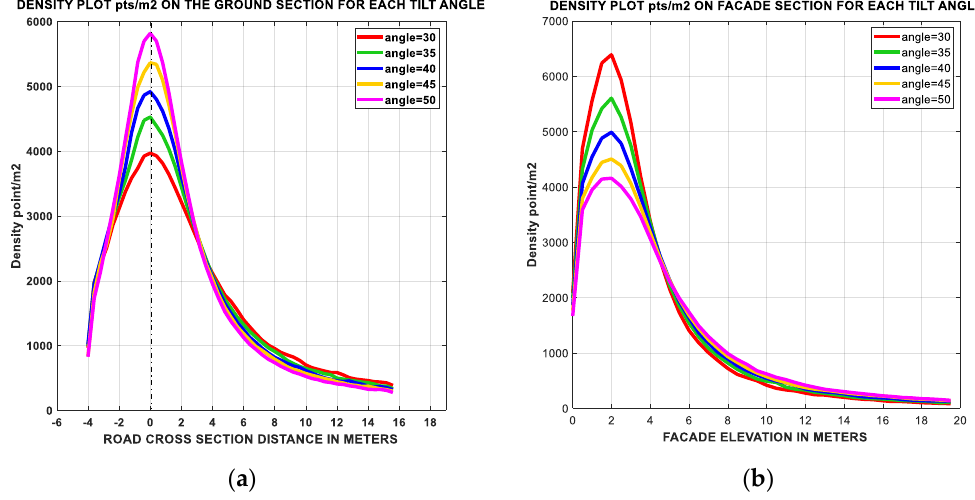
Figure 14. Pandar64 density checks on selected point clouds slices. ( a ) Density computed on the